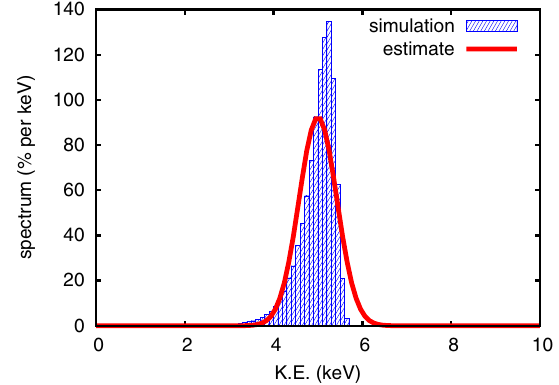
FIG. 6. Kinetic energy histogram for the same case as Fig. 5 but with energy straggling neglected. The equilibrium energy is about 5 keV, with an rms energy spread of about 0.4 keV and < 2% overall losses. For comparison we also show (solid line) the Gaussian fit based on a continuous medium